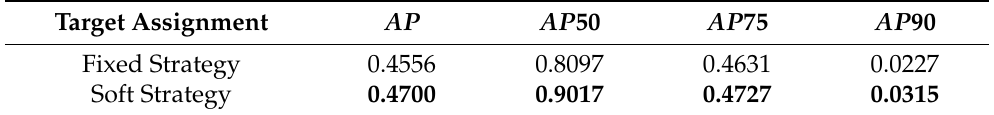
Table 4. Effectiveness of the Shape Descriptor.